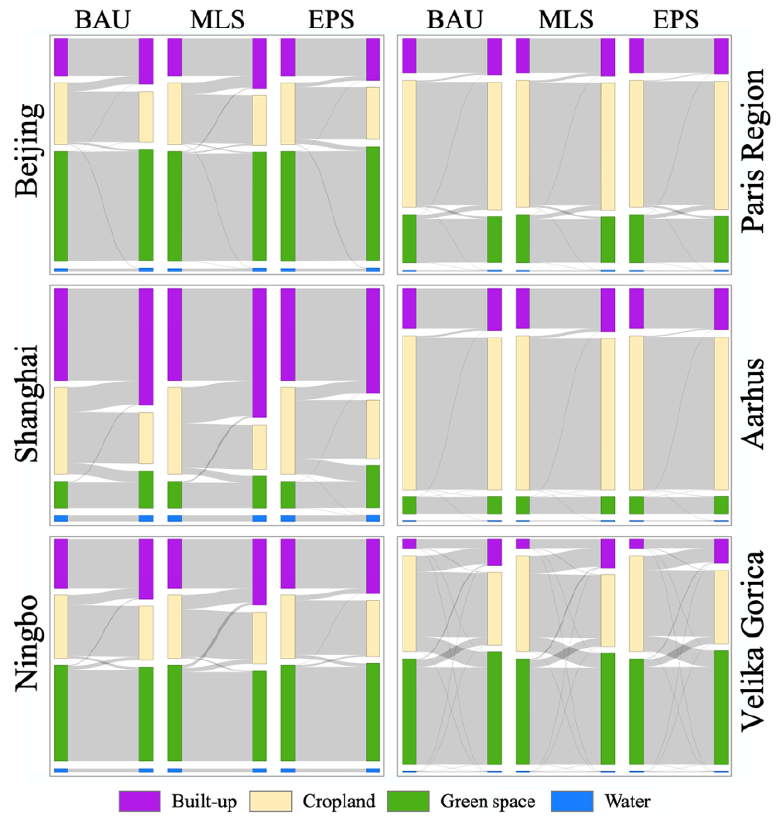
Figure A2. Land-cover transfer between 2020 and 2030 for various categories under different sce- narios.